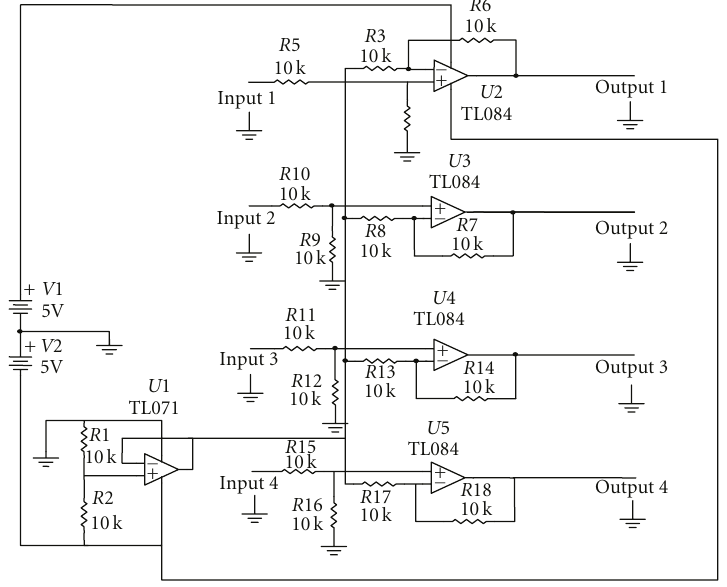
Figure 7: Voltage level shifter circuit